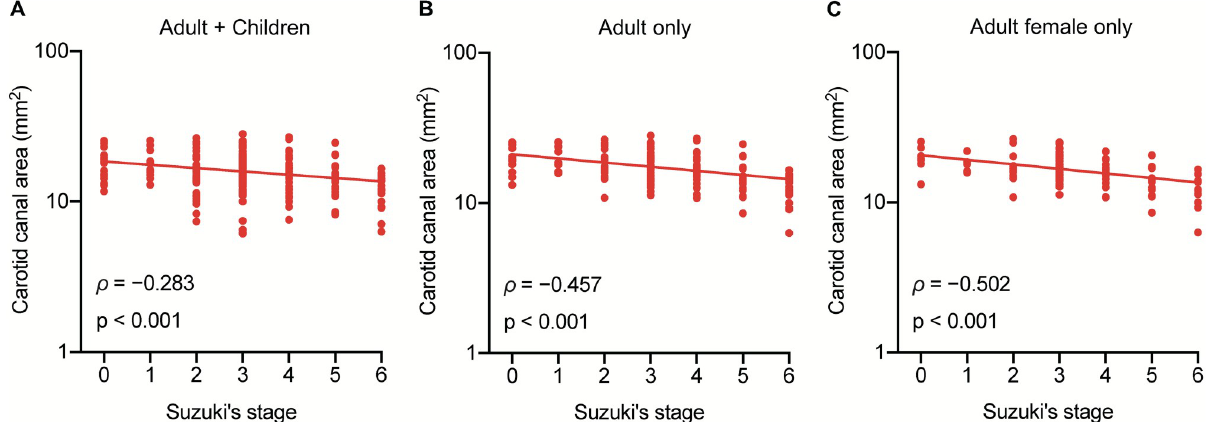
Fig 4. The carotid canal area is negatively correlated with Suzuki’s stage. (A) shows the distribution of the carotid canal area according to Suzuki’s stage in 106 patients with moyamoya disease. The image shows a significant inverse correlation in the carotid canal area with Suzuki’s stage ( ρ = − 0.283, p < 0.001). (B) shows adult-only analysis. There is an apparent inverse correlation with Suzuki’s stage ( ρ = − 0.457, p < 0.001). (C) shows adult female- only analysis. There is also an apparent inverse correlation with Suzuki’s stage ( ρ = − 0.502, p <